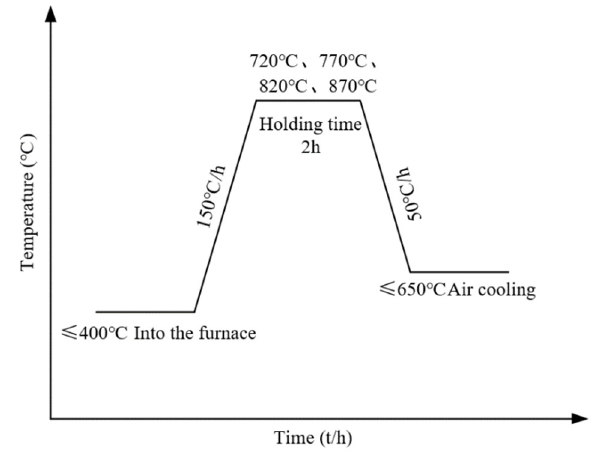
Figure 8. Heat treatment parameters and flow chart .